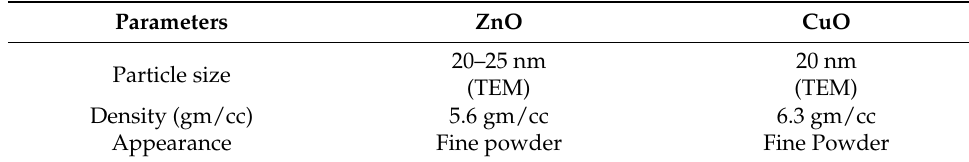
Table 1. Nanoparticle’s specifications.